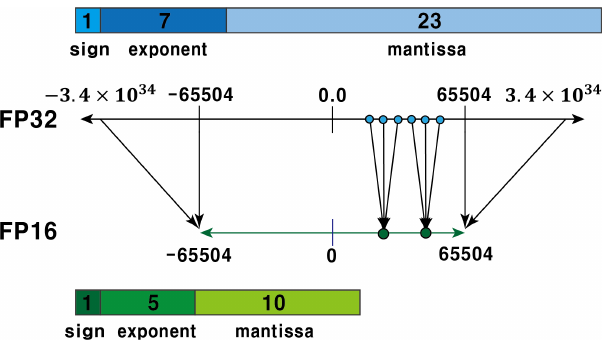
Figure 2. Quantization from FP32 to